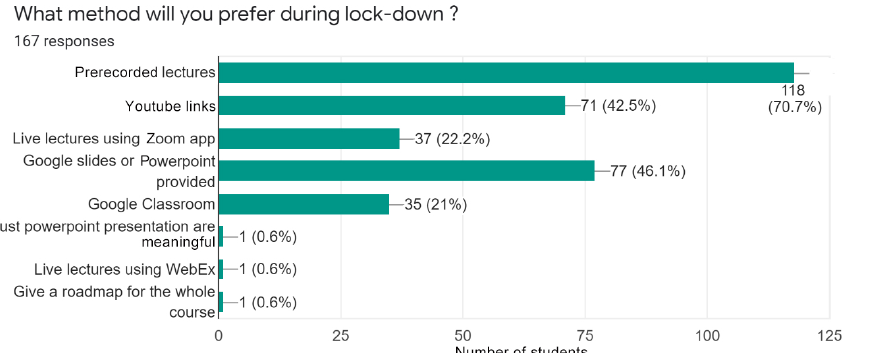
Fig. 1 Most important feature of e-learning for Thapar Institutes.